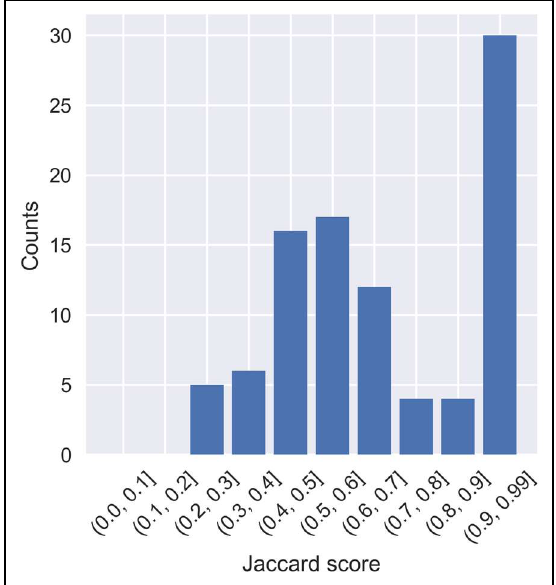
Figure 5. The distribution of Jaccard scores.